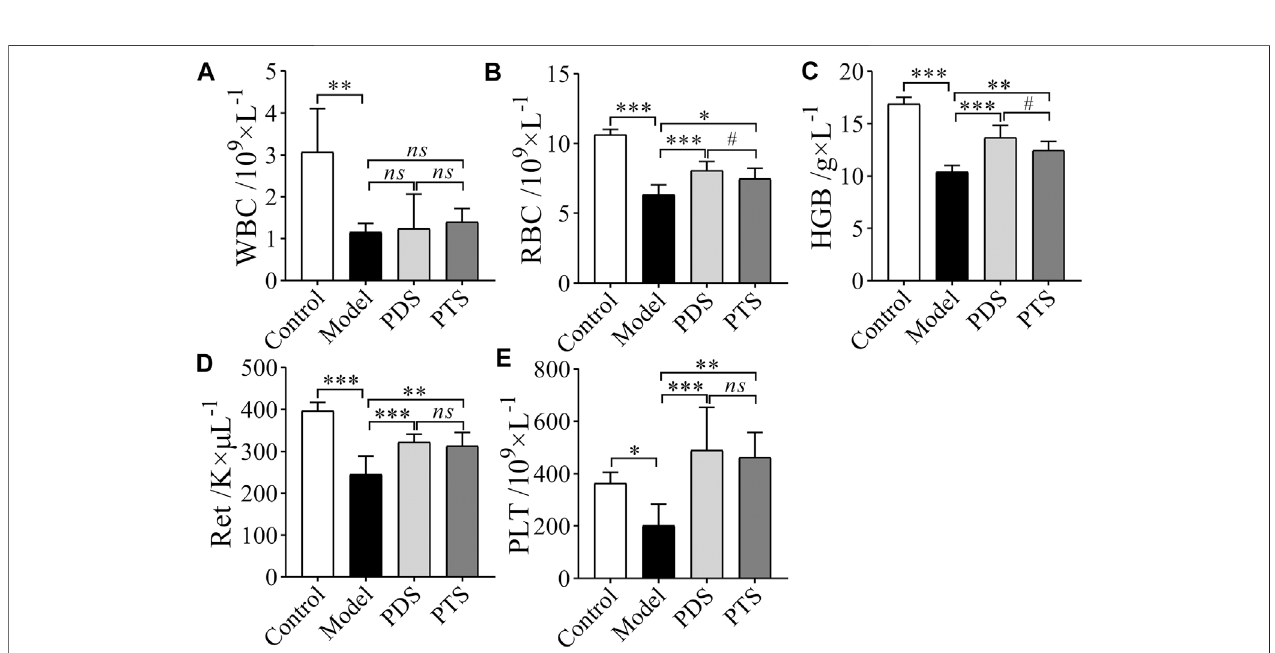
FIGURE 4 | The effect ofPDS and PTS on peripheral blood cells of myelosuppression mice. (A) White blood cell (WBC); (B) Red blood cell (RBC); (C) Hemoglobin (HGB); (D) Reticulocyte(Ret); (E) platelet(PLT).Thedataareexpressedasmean±SD( n =8),* p < 0.05,** p < 0.01and*** p < 0.001comparedwiththemodelgroup; # p < 0.05 compared with PTS group, ns showed no signi fi cance between the two groups.